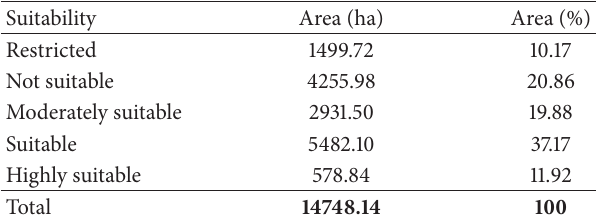
Table 6: Rain water harvesting